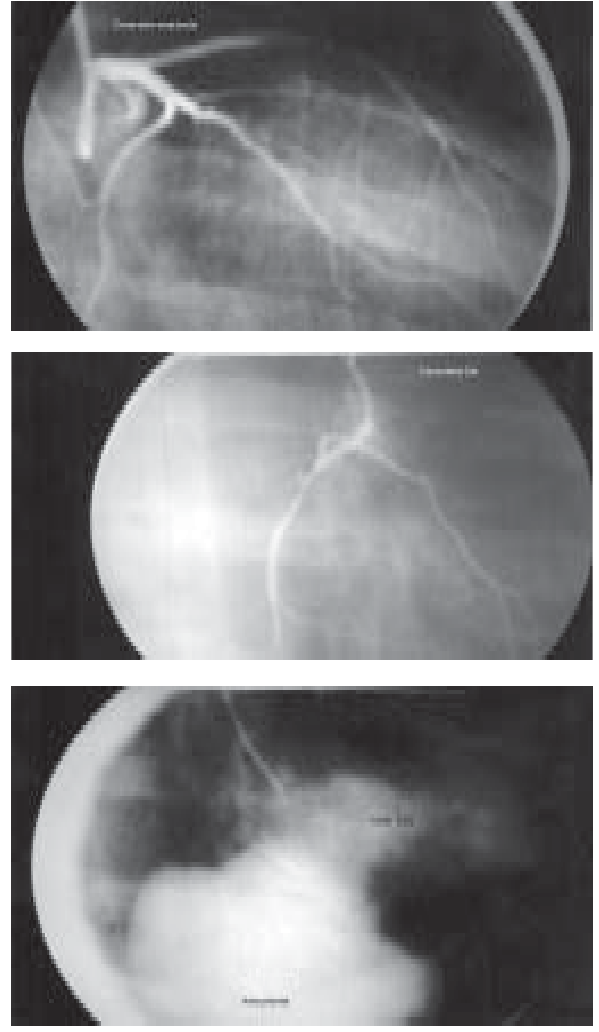
Fig. 1 - Cinecoronariografia revelando: a) Obstrução da artéria coronária direita e b) Artéria coronária esquerda normal. c) Ventriculografia esquerda mostrando enorme aneurisma inferior do ventrículo